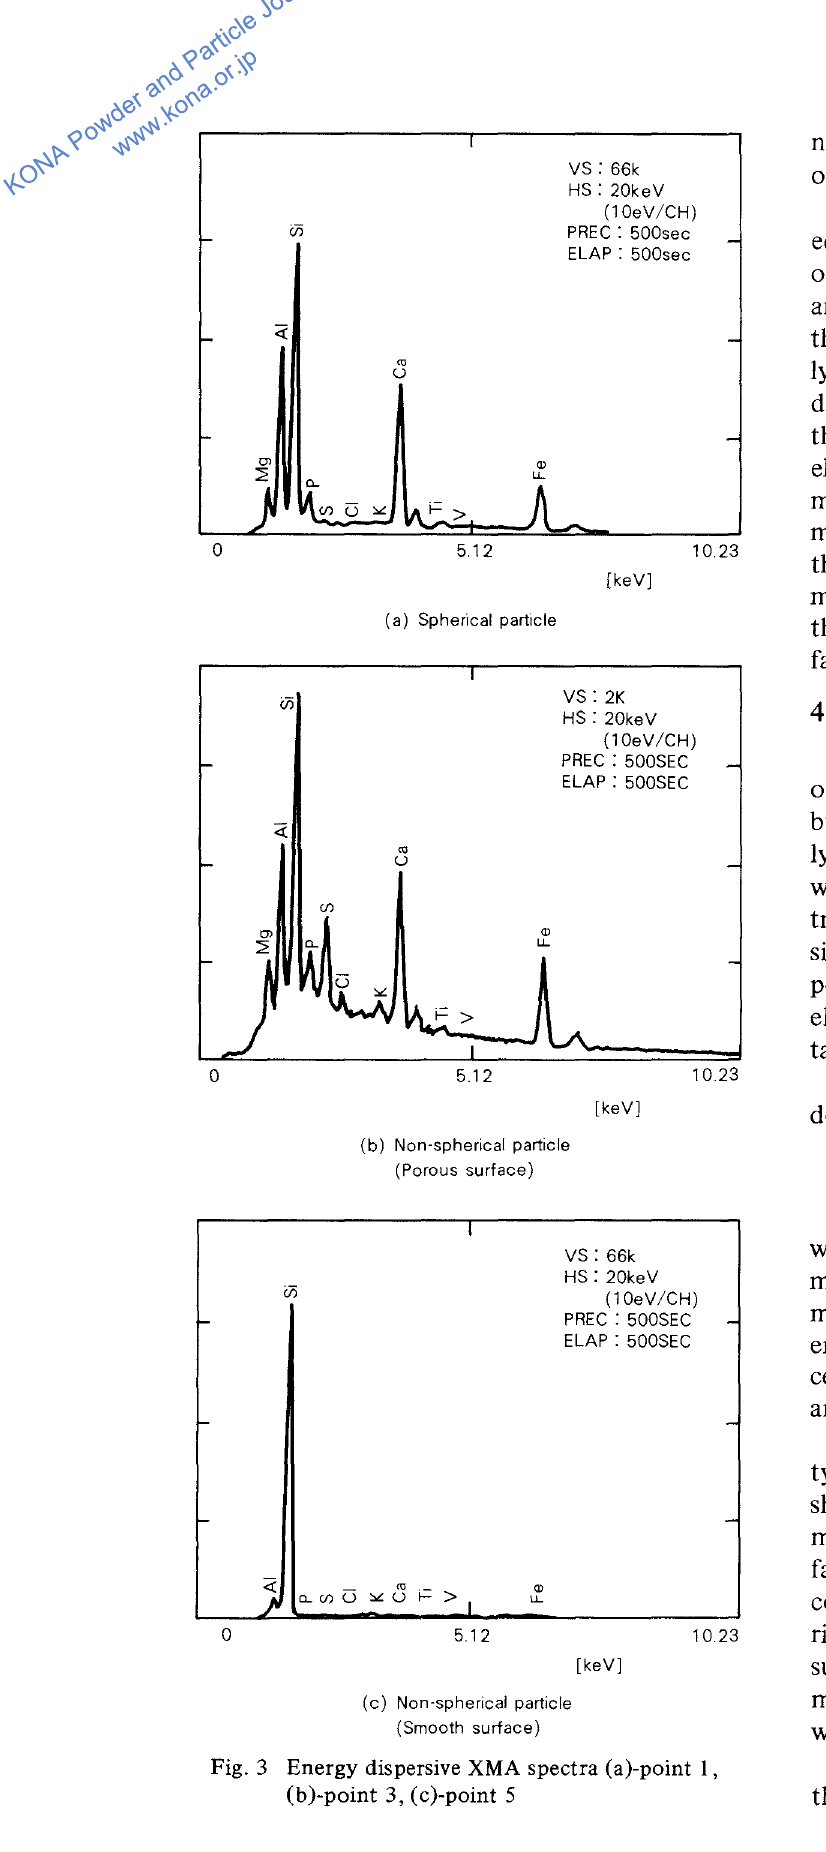
Fig. 3 Energy dispersive XMA spectra (a)-point 1, (b)-point 3, (c)-point